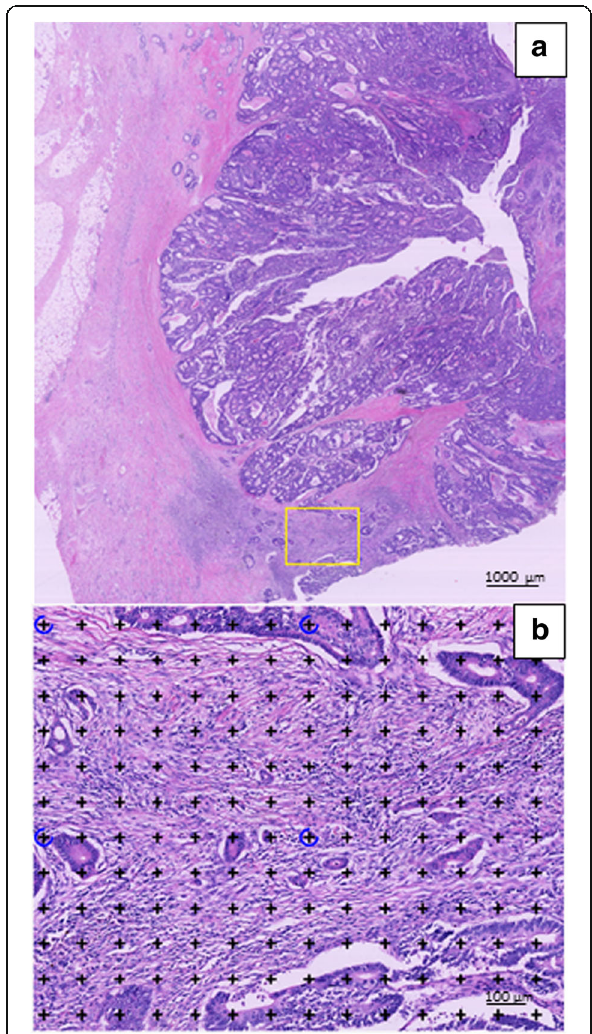
Fig. 1 Stereological estimation of tumour stroma ratio. a The area with the highest stroma density (yellow frame) is subjectively selected at low magnification (2×). b At higher magnification (10×) a grid of 4 x (6×7) points is superimposed on the selected area. Points hitting either tumour cells or stroma are counted separately. Tumour cells must to be present at all borders of the visual field